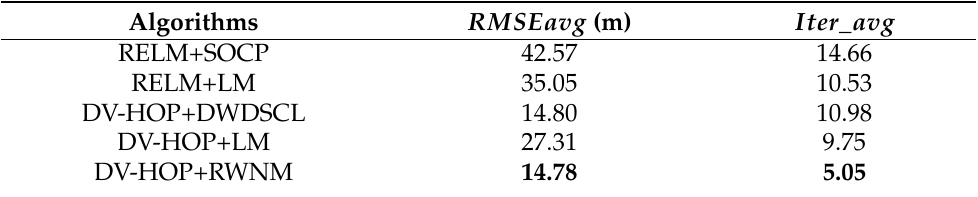
Figure 5. ( a ) RMSEavg and ( b ) Iter _ avg after running five iterative algorithms over 10 multi-hop isotropic networks with R = 45 m and nfe = 0.1. Outliers levels are increased by steps of 10% from 0% to 50%. Table 4. RMSEavg and Iter _ avg at different outliers values using R = 45 m and nfe = 0.1, the best performances in RMSE average and iteration average are denoted in bold face.